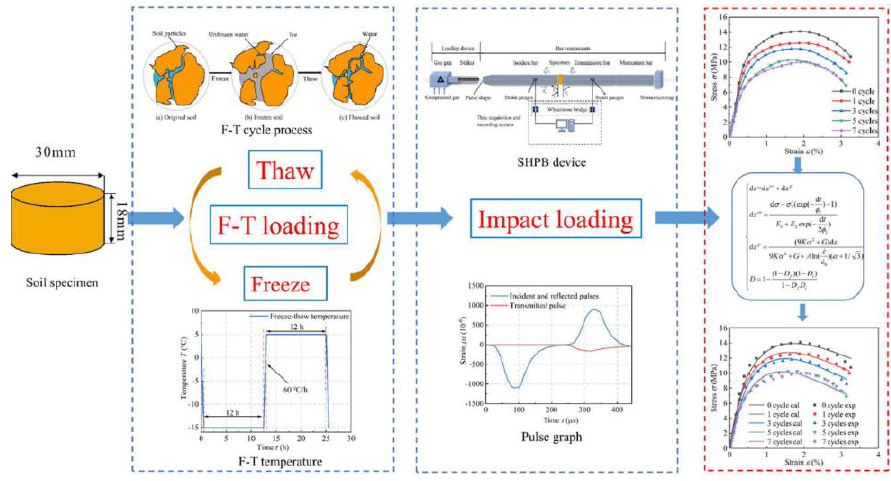
Figure 24. Research procedure of the conducted SHPB experiment (reprinted from Ref. [88]). (XIX)